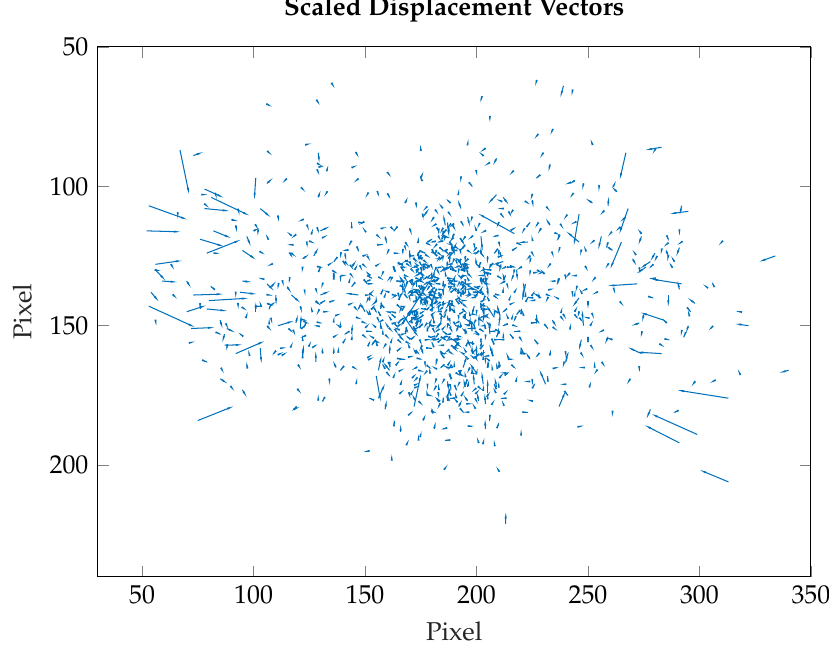
Figure 7. The vector plot illustrates the displacement of reference to detection points. Every vector starts at a reference and points towards the detected location. The length is scaled down by 2.5 to add the visibility of the vector field. The highest displacement is located at the left and right of the image